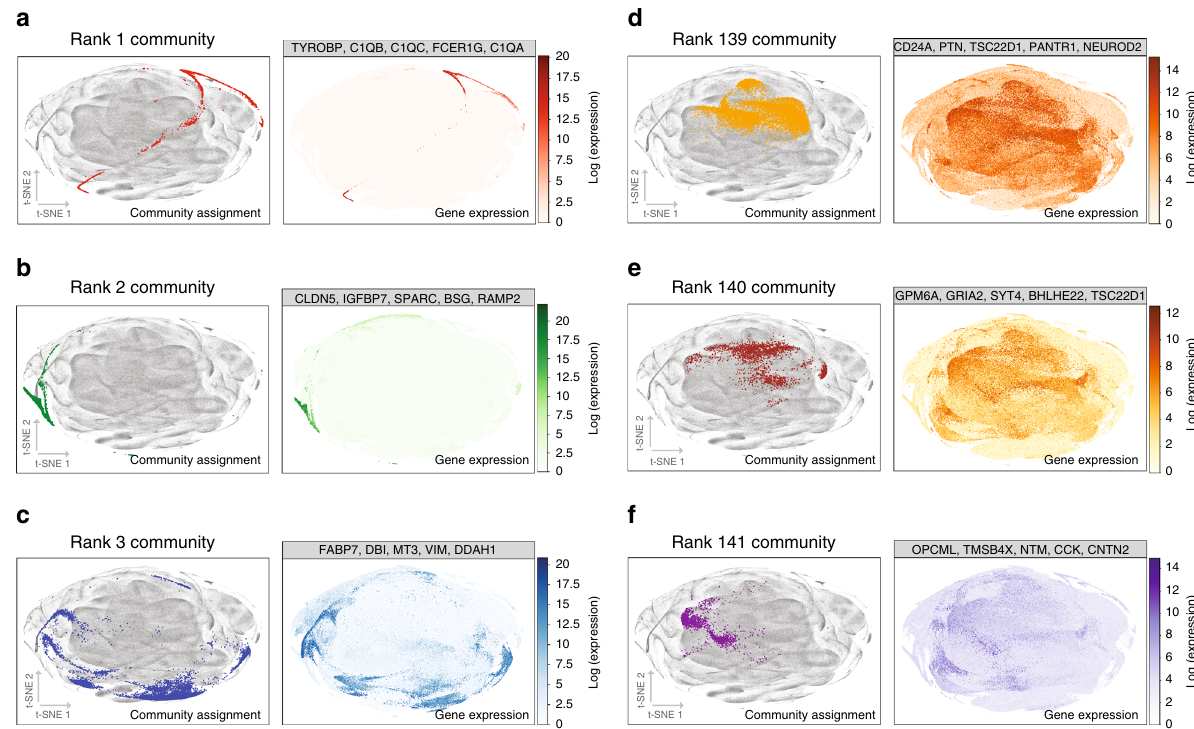
Fig. 4 Prioritizing network communities in the megascale cell – cell similarity network. The network of embryonic mouse brain has 1,306,127 nodes representing brain cells 29 . Communities are detected using a community detection method developed for single-cell RNA-seq data 8 and prioritized using CR ANK , generating a rank-ordered list of detected communities. a – c Shown are three communities that are ranked high by CR ANK ; a rank 1, b rank 2, and c rank 3 community. t-SNE projections 39 show cells assigned to each community. t-SNE is a dimensionality reduction technique that is particularly well suited for visualization of high-dimensional data. Cells assigned to each community are distinguished by color, and all other cells are shown in gray. We investigate the quality of community ranking by examining gene markers for cells in each community 28 . We use the single-cell RNA-seq data set to obtain a gene expression pro fi le for each cell, indicating the activity of genes in the cell. For each community we then identify marker genes, i.e., genes with the strongest differential expression between cells assigned to the community and all other cells 9 . In the t-SNE projection we then color the cells by how active the marker genes are. This investigation reveals that communities ranked high by CR ANK are represented by clusters of cells whose marker genes have a highly localized expression. For example, marker genes for rank 1 community in a (the highest community in CR ANK ranking) are TYROBP , C1QB , C1QC , FCER1G , and C1QA . Expression of these genes is concentrated in cells that belong to the rank 1 community. Similarly, marker genes for rank 2 and rank 3 communities are speci fi cally active in cell populations that match well the boundary of each community. d – f t-SNE projections show cells assigned to 3 low-ranked communities; d rank 139, e rank 140, and f rank 141 community. t-SNE projections are produced using the same differential analysis as in a – c . Although these communities correspond to clusters of cells in the t-SNE projections, their marker genes have diluted gene expression that is spread out over the entire network, indicating that CR ANK has correctly considered these communities to be low priority. For example, marker genes for rank 141 community in f are OPCML , TMSB4X , NYM , CCK , and CNTN2 , which show a weak expression pattern that is diffused across